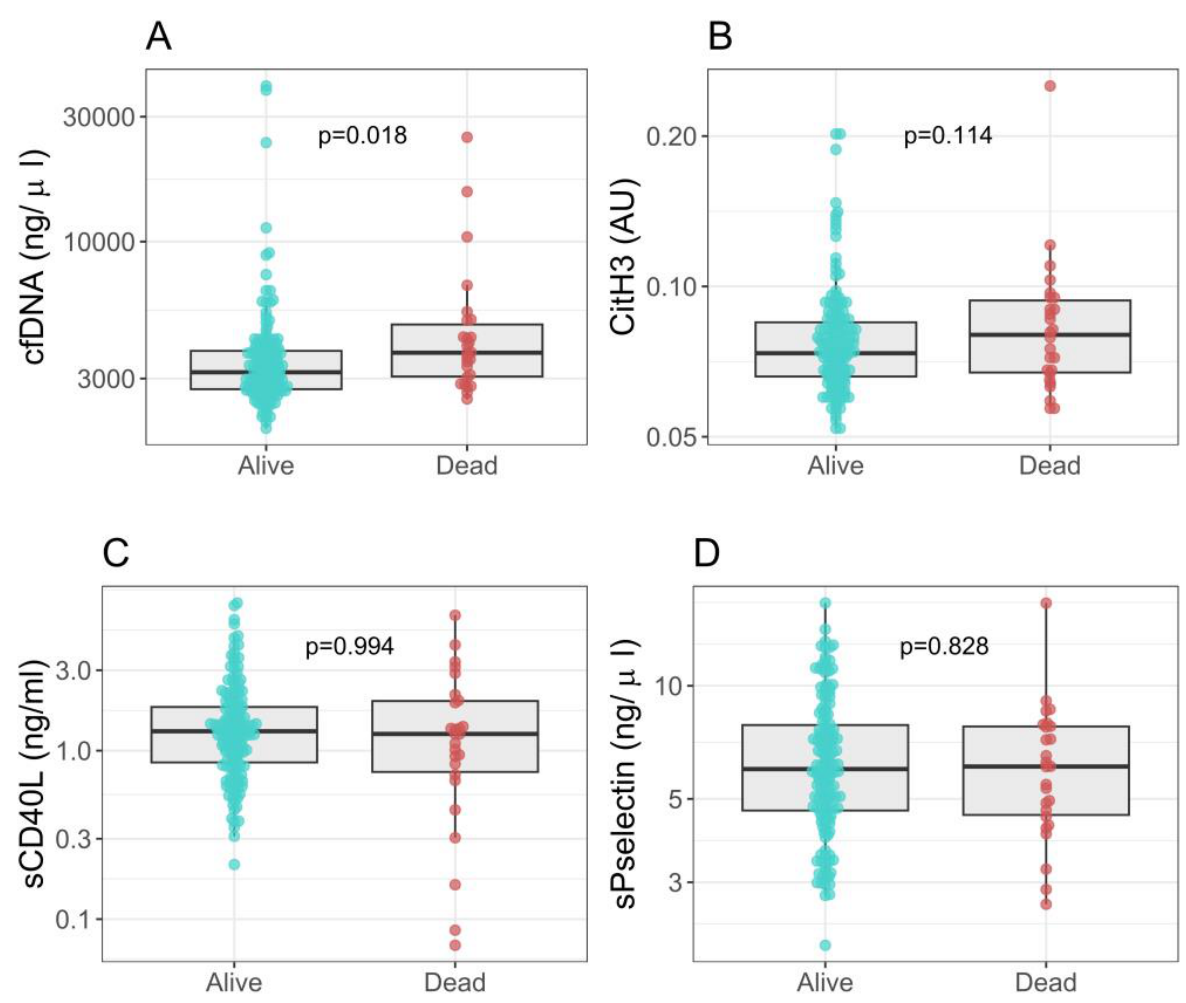
Figure 3. Neutrophil extracellular traps, platelet activation markers and death. ( A ) cfDNA levels; OR 2.27 [1.18, 4.55], p = 0.018. ( B ) CitH3 levels; OR 3.19 [0.70, 13.10], p = 0.114. ( C ) sCD40L levels; OR 1.00 [0.68, 1.36], p = 0.994. ( D ) sP-selectin levels; OR 0.98 [0.83, 1.14], p = 0.828. AU: arbitrary units.